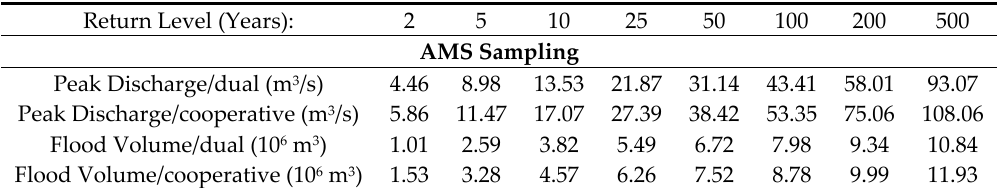
Figure 3. Level curves for the bivariate return periods, black for cooperative risk T OR and brown for dual risk T AND . The color range changes as the probability reaches from 0 to 1. U denotes F X (X) which represents the random variable from the marginal distribution of the peak discharge values and V denotes F Y (Y) which represents the random variable from the marginal distribution of the flood volume values. Each of the lines refer to a specific return period and the values on the two axis are equivalent to the probabilities of occurrence of the random variables X (peak discharge) and Y (flood volume) respectively. Table 2. Results of the Bivariate Return Periods 2, 5, 10, 25, 50, 100, 200 and 500 for Peak Discharge and Flood Volume using Annual Maximum Series (AMS)